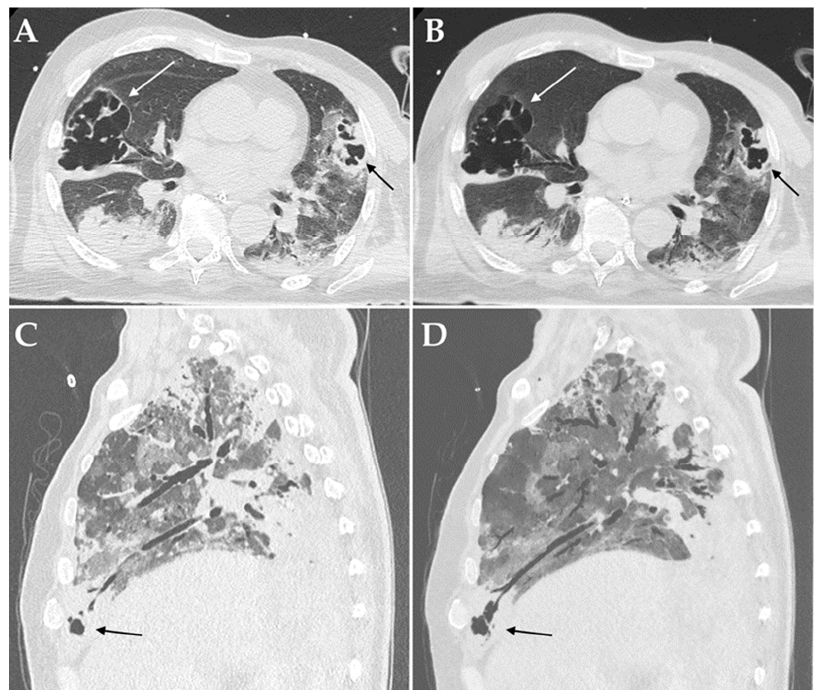
Figure 3. Axial HRCT images of a patient admitted to ICU with confirmed superinfection by Aspergillus fumigatus showing pulmonary consolidations in the lower lobes complicated by bilateral cavitations (white and black arrows in ( A )); Minimum Intensity Projection (MIP) reconstruction of the same patient demonstrating communication between the cavitations and the bronchial tree (white and black arrows in ( B )). Sagittal HRCT images of a patient admitted to ICU with confirmed superinfection by Aspergillus niger showing pulmonary consolidations in the anterior-basal segment of the right lower lobe complicated by small cavitations (black arrow in ( C )); Minimum Intensity Projection (MIP) reconstruction of the same patient demonstrating communication between the cavitation and the bronchial tree (black arrows in ( D )).